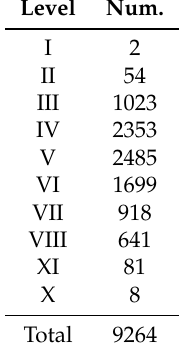
Table 4. Number of multimedia web document for each level of DMOZ